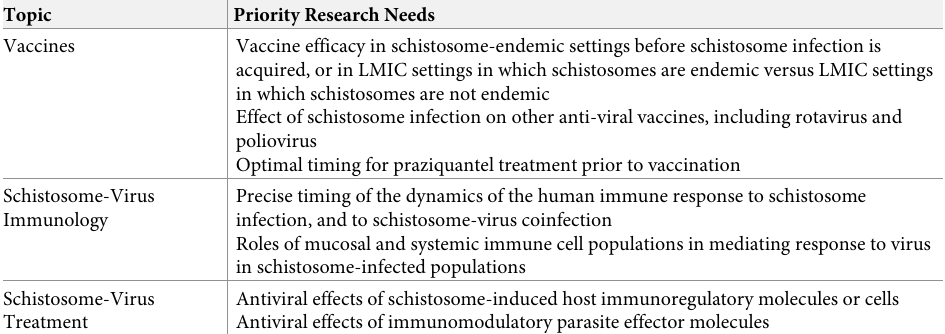
Table 10. Broad Priority Research Areas for Schistosome-Virus